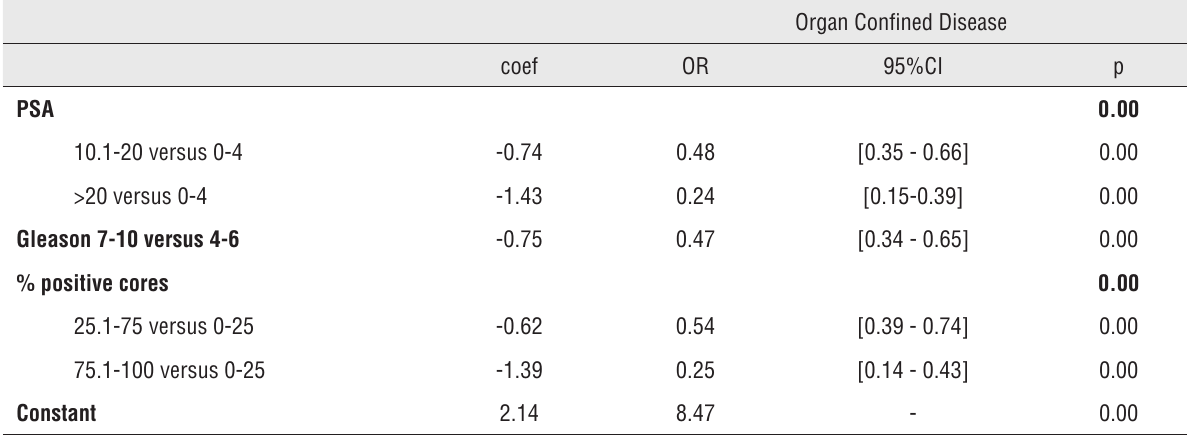
Table 3 - Multivariate analysis for prediction OCD and IVS.